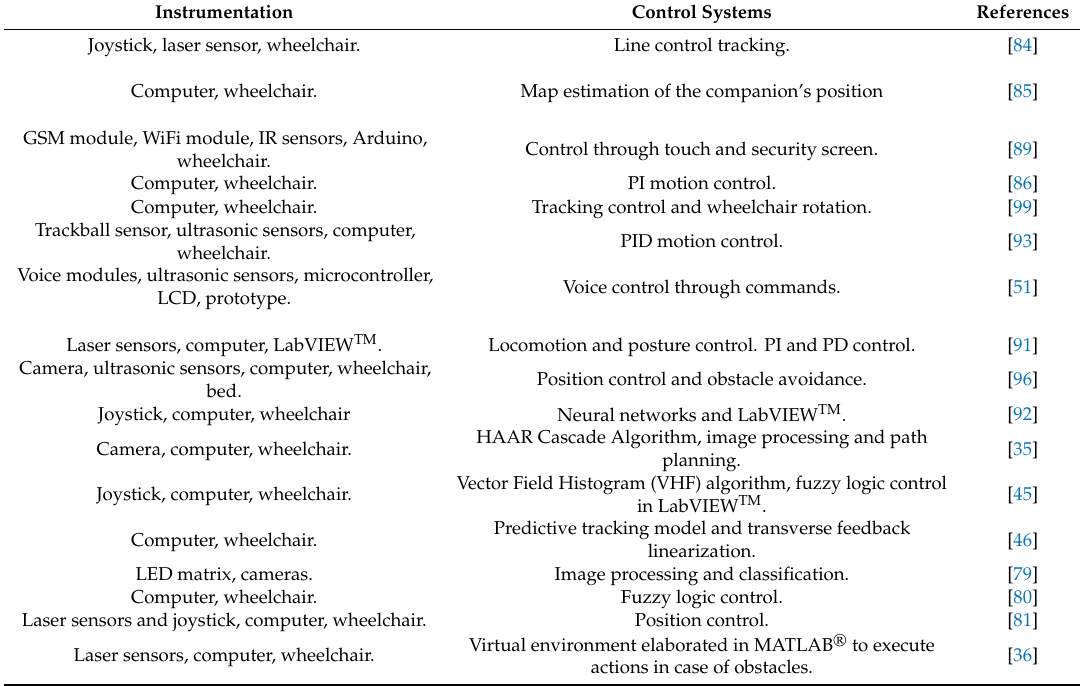
Table 10. Instrumentation and control strategies for wheelchair